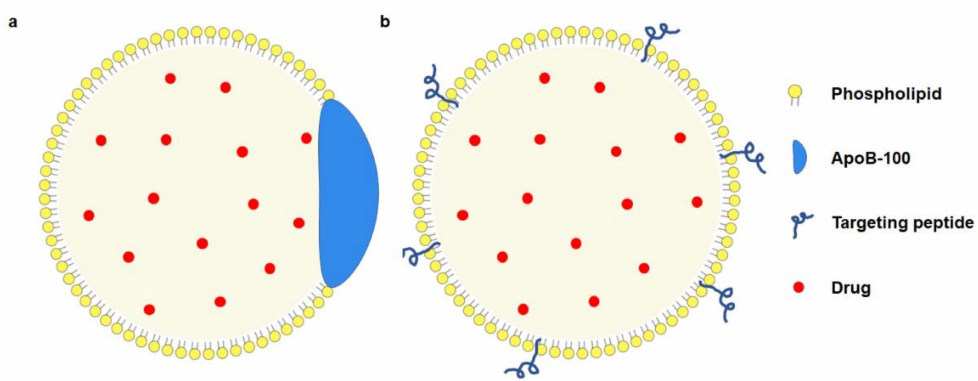
Figure 4. The modification strategy of sLDL-drugs. ( a ) targeting function is provided by ApoB-100; ( b ) targeting function is provided by biomimetic peptide.